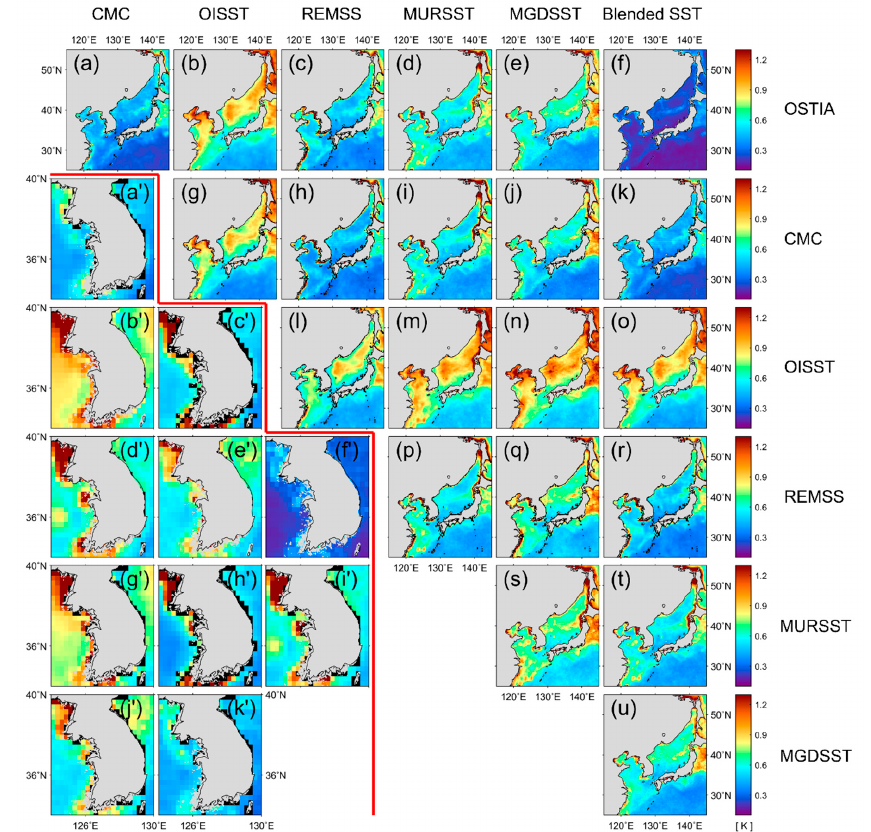
Figure 11. Spatial distribution of the root-mean-squared (RMS) differences of ( a ) CMC analysis, ( b ) OISST, ( c ) REMSS analysis, ( d ) MURSST, ( e ) MGDSST, and ( f ) Blended SST for the OSTIA; ( g ) OISST, ( h ) REMSS analysis, ( i ) MURSST, ( j ) MGDSST, and ( k ) Blended SST for the CMC analysis; ( l ) REMSS analysis, ( m ) MURSST, ( n ) MGDSST, and ( o ) Blended SST for the OISST; ( p ) MURSST, ( q ) MGDSST, and ( r ) Blended SST for the REMSS analysis; ( s ) MGDSST and ( t ) Blended SST for the MURSST; ( u ) Blended SST for the MGDSST. ( a’ – k’ ) are enlarged from ( a – k ), respectively.